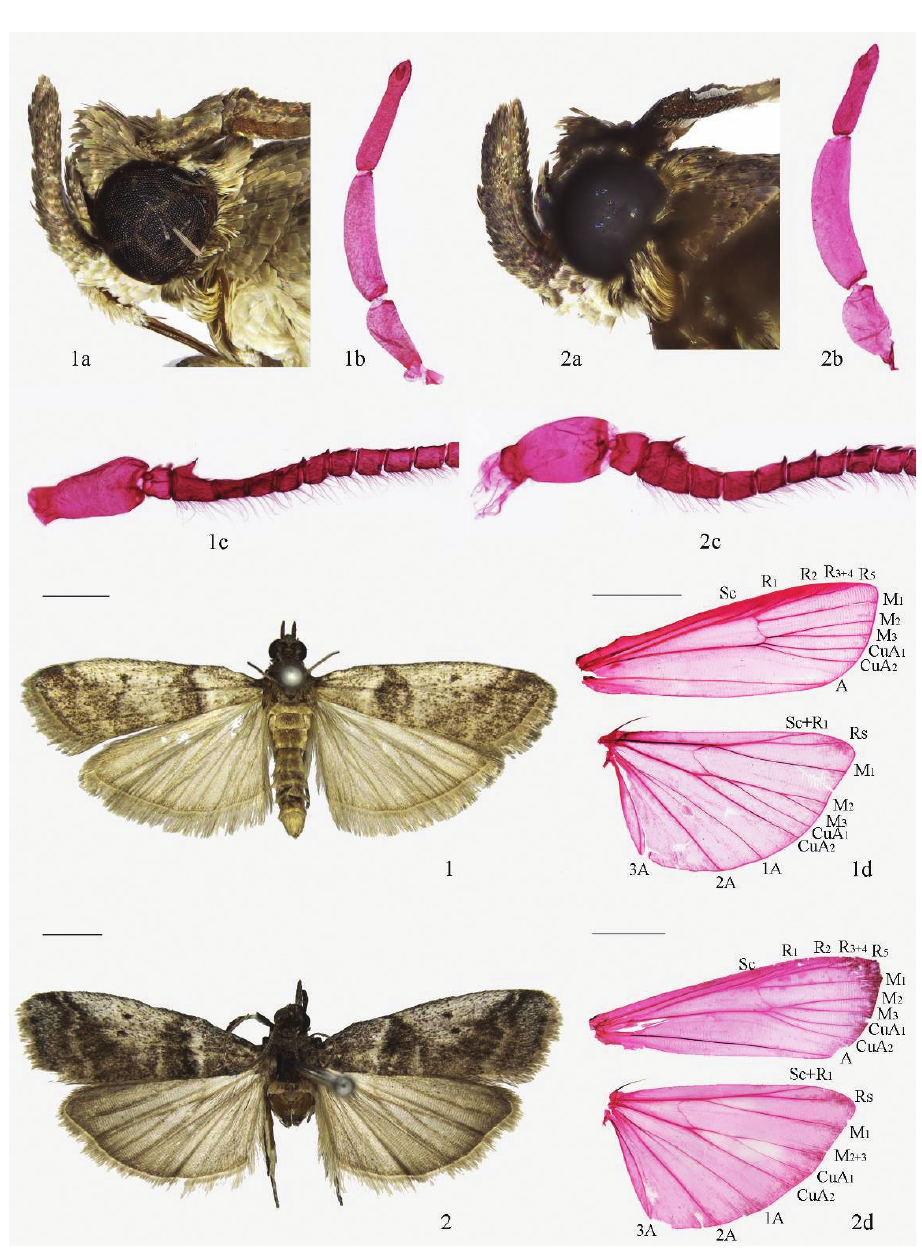
Figures 1−2. Adult of Pseudacrobasis species: 1 P . dilatata sp. n. ( 1a head 1b labial palpus, slide No. YLL15173 1c Antenna, slide No. YLL15173 1d wing, slide No.YLL15171w) 2 P . tergestella ( 2a head 2b labial palpus, slide No. YLL15175 2c Antenna, slide No. YLL15175 2d wing, slide No. LJY10581w). Scale bars: 2.0